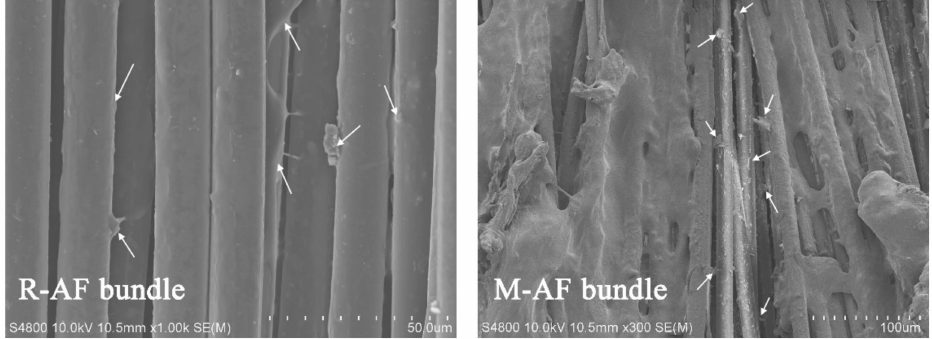
Figure 10. Interlaminar fracture surface morphology after a pull-out